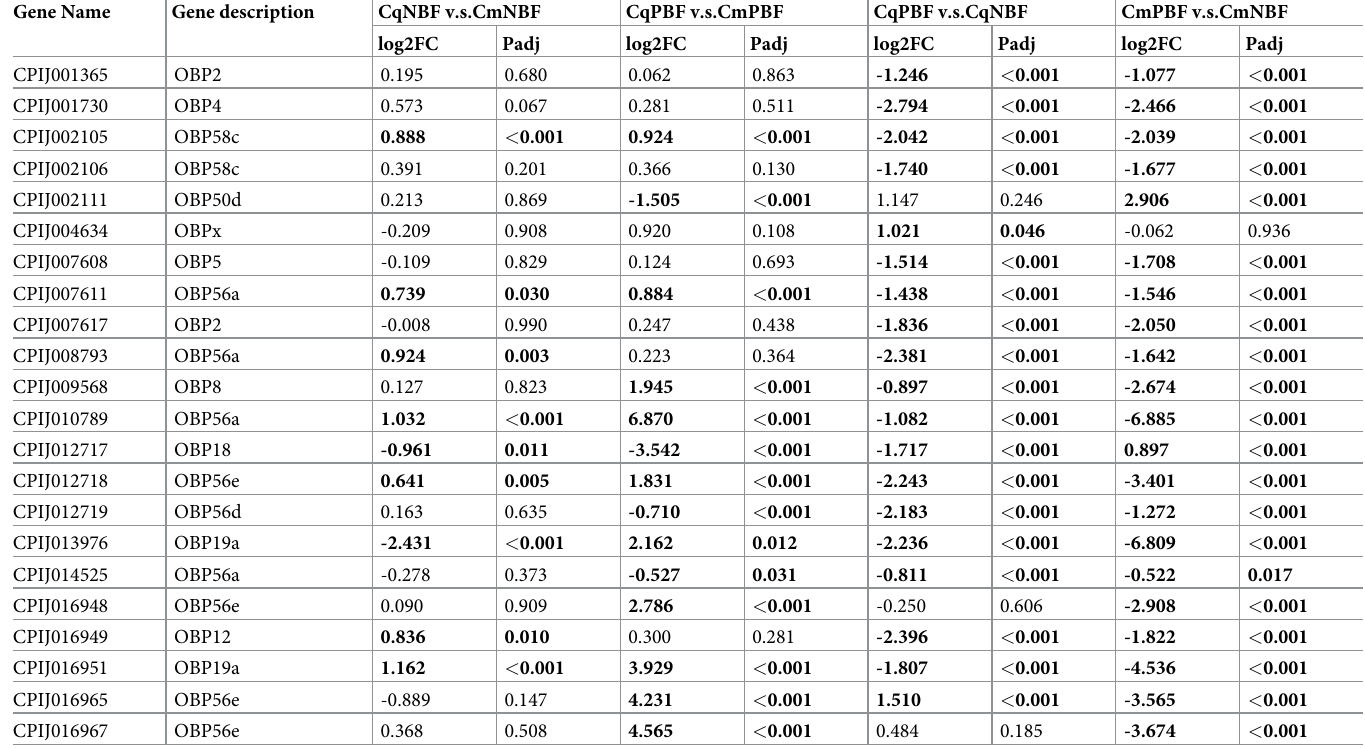
Table 1. Significant differentially expressed OBP genes among the four compared groups. Gene Name Gene